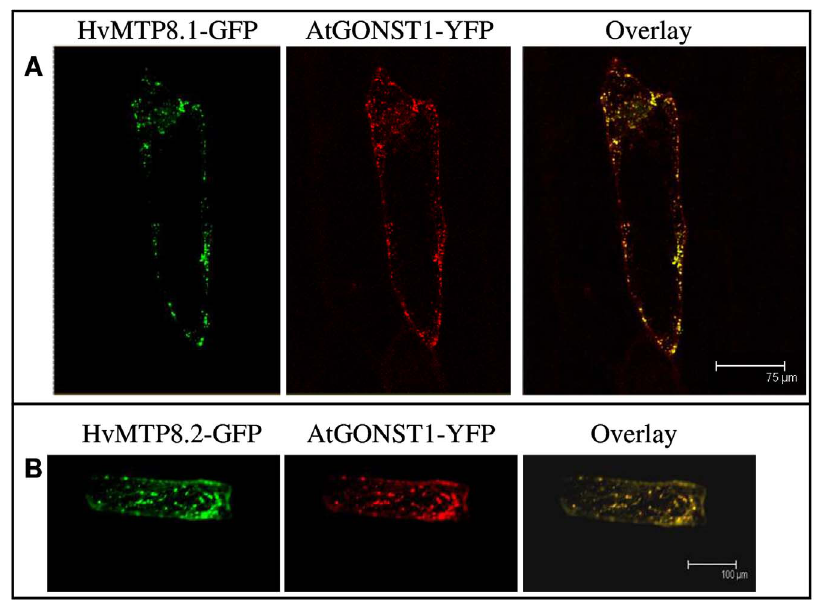
Fig. 3. C-terminal MTP8-GFP fusion proteins localizes to the Golgi apparatus. As a control, GONST1- YFP were transiently co-expressed with MTP8.1-GFP and MTP8.2-GFP in onion epidermal cells (A and B), respectively. The right panels show co-localizations of GONST1-YFP with each MTP8-GFP protein. Scale bars were 75 and 100 m m for A and B, respectively. (Fig. 3A and B, left panel). The MTP8-GFP localizations to Golgi were supported by co-expression of the Golgi-localized marker protein GONST1 fused to YFP [48] (Fig. 3A and B, right panel). A co-localization analysis was performed resulting in correlation coefficients of 0.81 ¡ 0.03 and 0.85 ¡ 0.05 for HvMTP8.1 and HvMTP8.2, respectively.